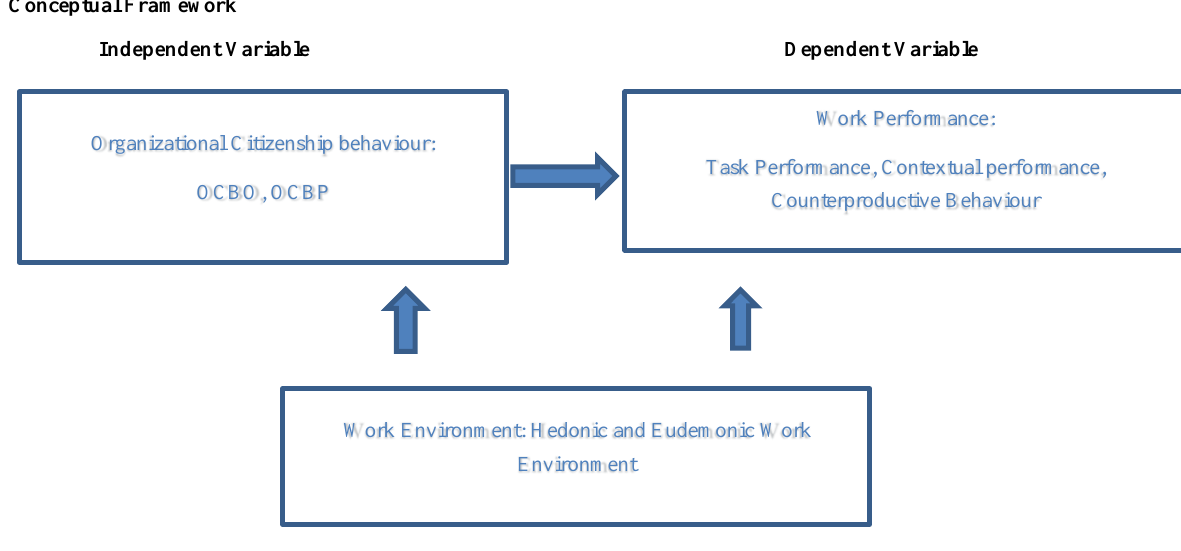
Figure 1 : The conceptual framework reflects the correlation between organizational citizenship behaviour and work performance. However, both, organizational citizenship behaviour and work performance can be affected by the work environment; Source: Spector (n.d) and Koopmans, et.al. (2011), National Library of Medicine (2020)